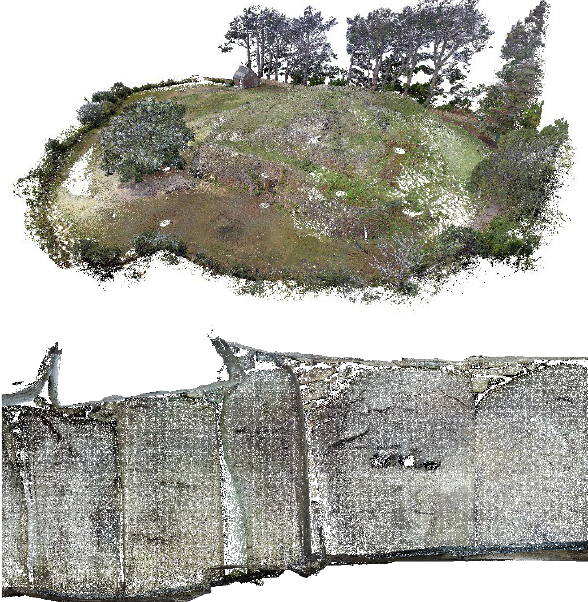
Figure 2. Overview of the point cloud and details of the interior